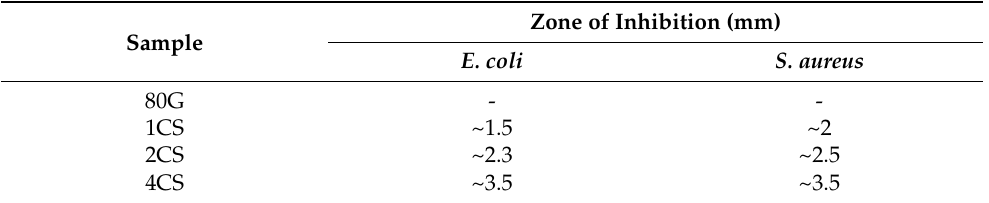
Table 3. The diameters of the zone of inhibition for all MBG